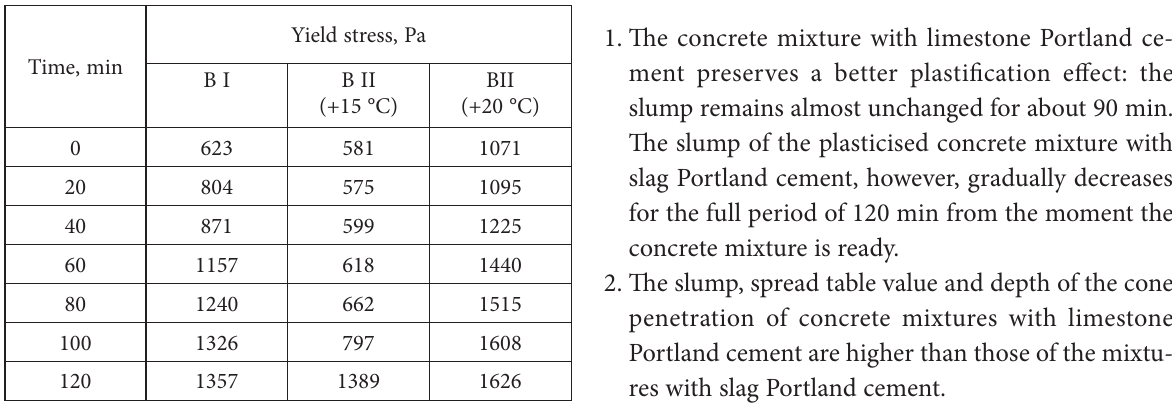
Table 7. The yield stress of concrete mixtures with